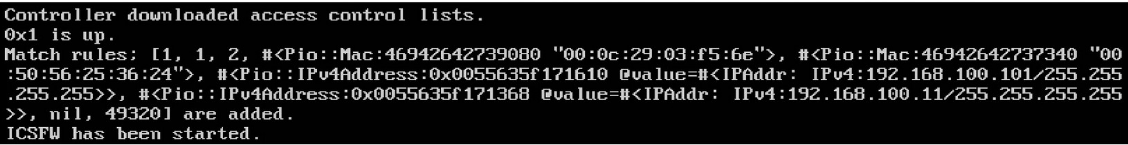
Figure 8. Firewall Controller’s